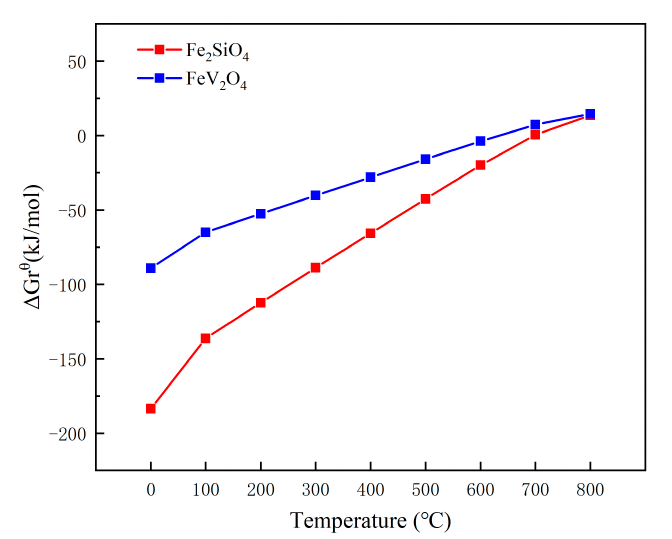
Figure 2. Gibbs free energy variation for Reactions (1) and (2) with different temperatures.